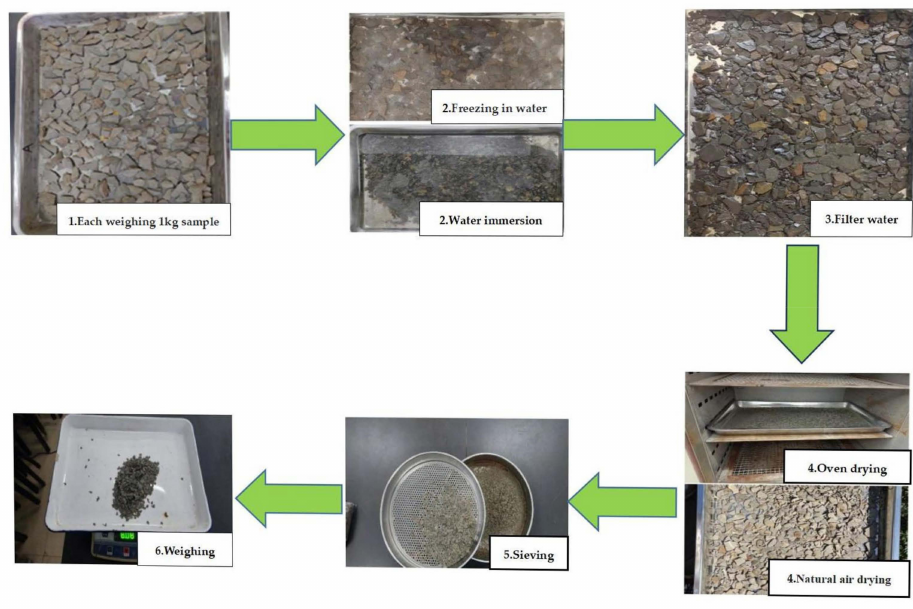
Figure 4. Test operation